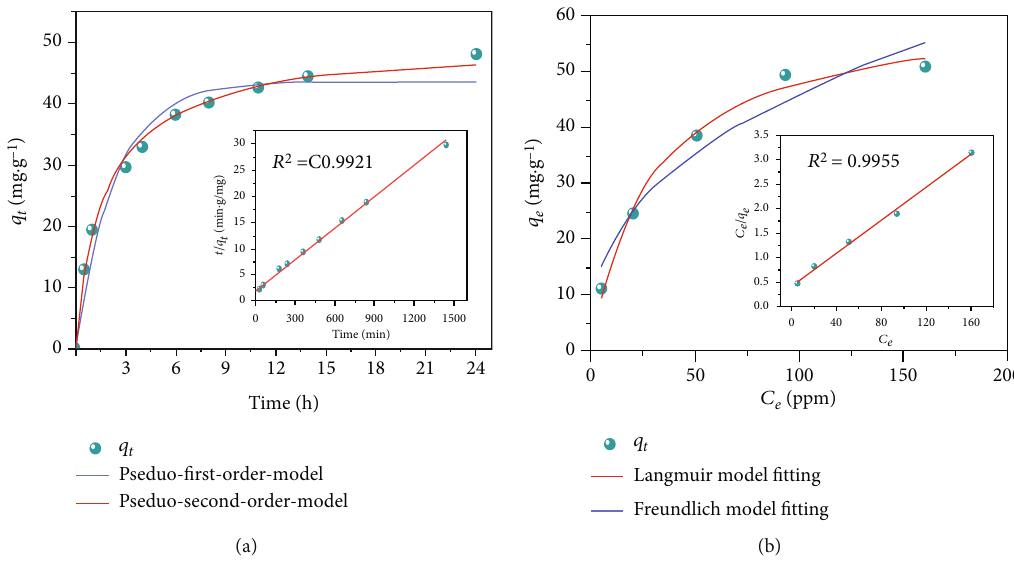
Figure 4: (a) Adsorption kinetics of PEI@wood aerogel for Cu(II). Inset: pseudo-second-order kinetic plot; (b) adsorption isothermal of PEI@wood aerogel for Cu(II). Inset: linear regression by fi tting the data with the Langmuir adsorption